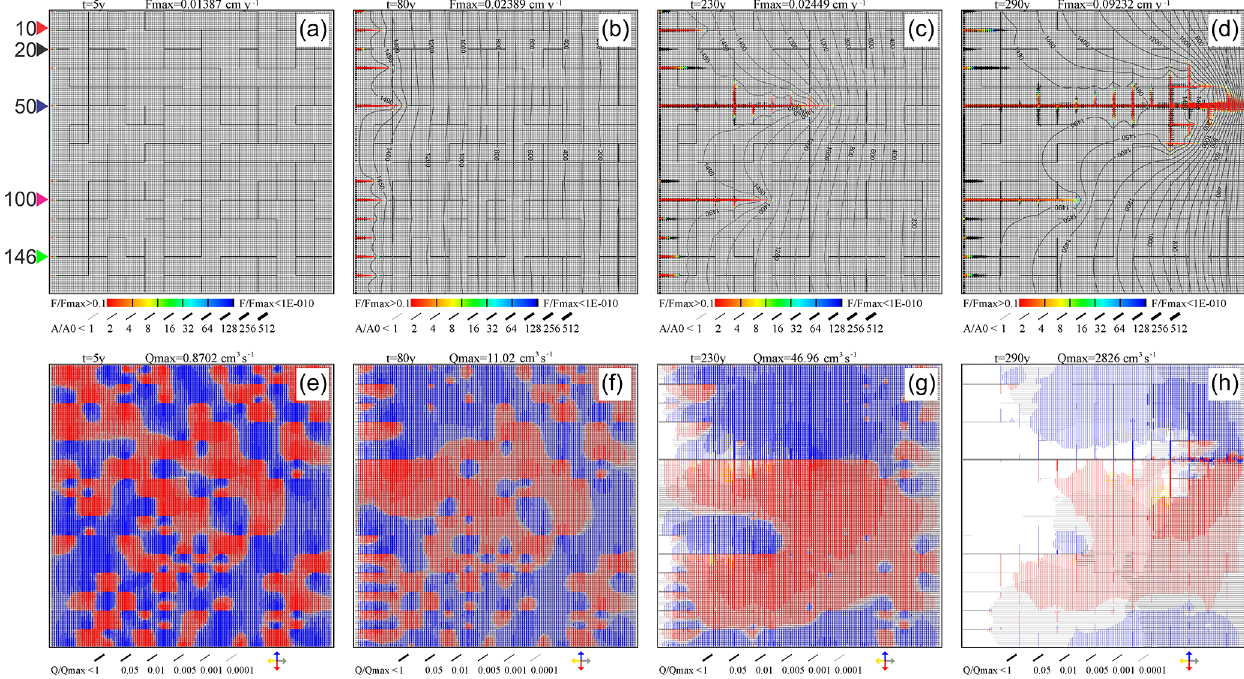
Figure 17. Evolution of wormholes in a dual network. The network is a superposition of the basic network (Fig. 3) and a crude net of prominent fractures with A 0 = 0 . 03cm, length 20m, and occupation probability 0.72. (a–d) Aperture widths and dissolution rates. (e– h) Flow rates and directions.